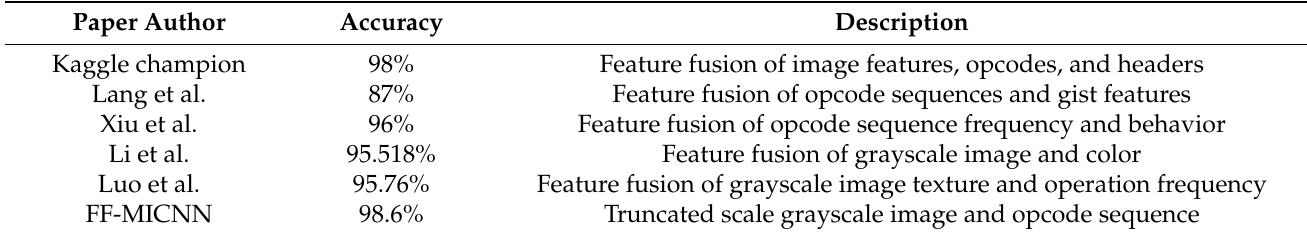
Table 8. Comparison of different